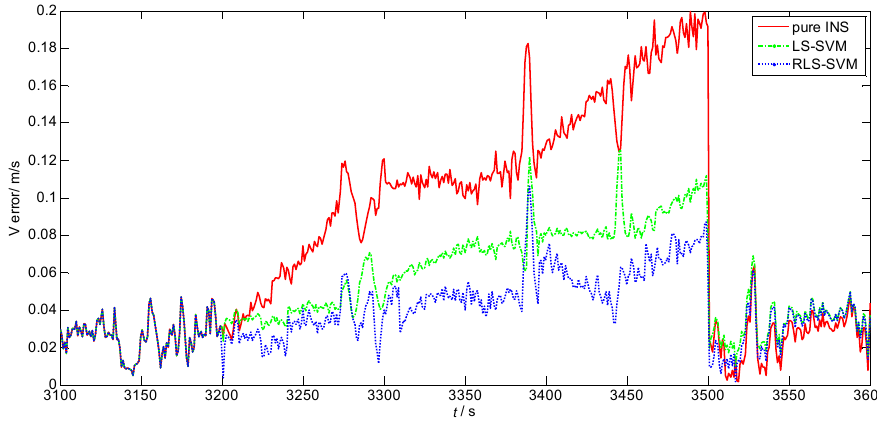
Figure 3. Velocity errors among different algorithms.